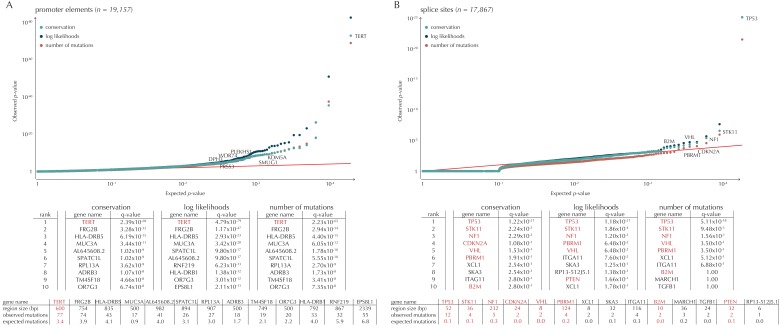
Q-values and top-ten ranking non-coding elements for each of the three proposed scoring schemes.The results discussed in the text relate to conservation scores. Non-coding elements associated to COSMIC genes are highlighted in red. For each element, the region size is given together with the observed number of mutations and the expected number of mutations under the null model. (A) The QQ-plot shows the p-values for all promoter elements (n = 19,157) plotted against their uniform expectation under the null. One hundred and sixty promoter elements are found to be significant. (B) QQ-plot of p-values for all splice sites (n = 17,867). The p-values do not follow the expectation under the null. This is explained by the fact that 90% of all splice sites carry no mutations. Three splice sites come up significant with ncdDetect after correcting for multiple testing.DOI:
http://dx.doi.org/10.7554/eLife.21778.02110.7554/eLife.21778.022Figure 5—source data 1.P-values obtained on promoters and splice sites using conservation scores.This data set relates to Figure 5A–B. P-values obtained using log-likelihoods and number of mutations as scores are in Supplementary files 2–3.